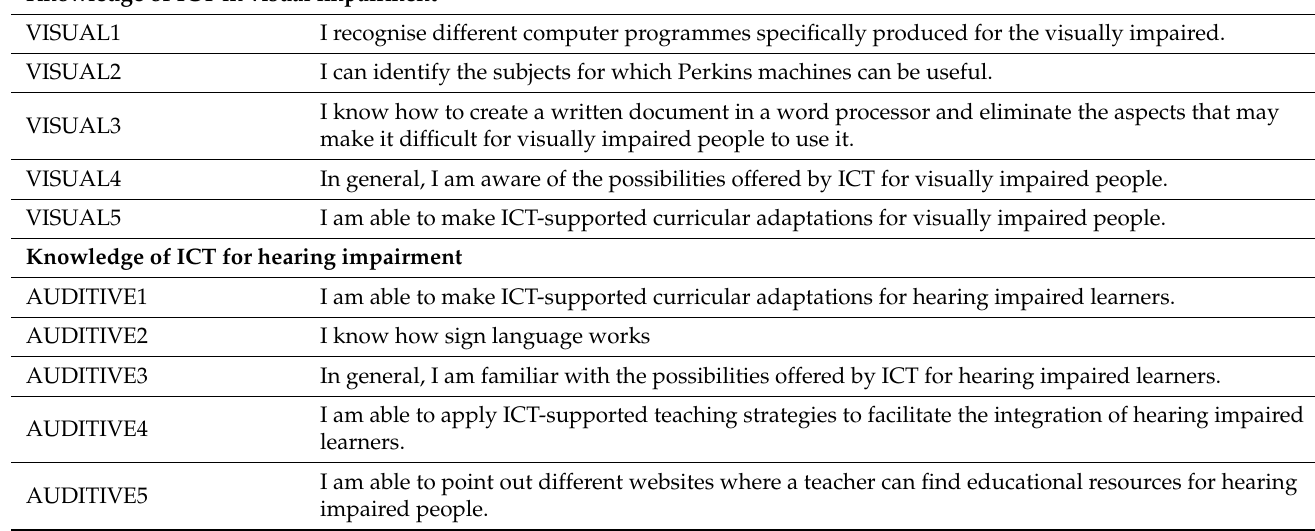
Table A1. Items of the scales